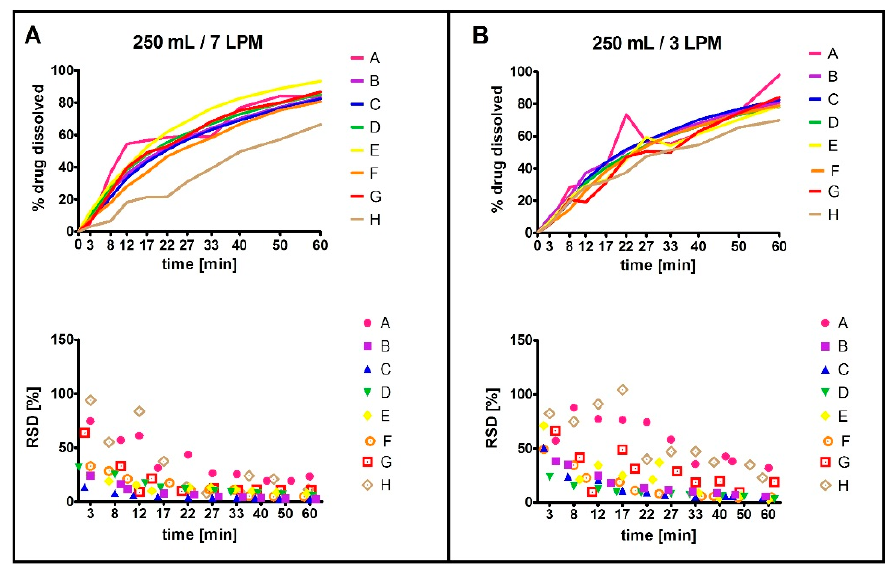
Figure 3. Dissolution data from Phase 1 (250 mL), tested at 7 LPM ( A ) and 3 LPM ( B ) agitation rate. The bottom graphs show the individual RSD values for each time point.